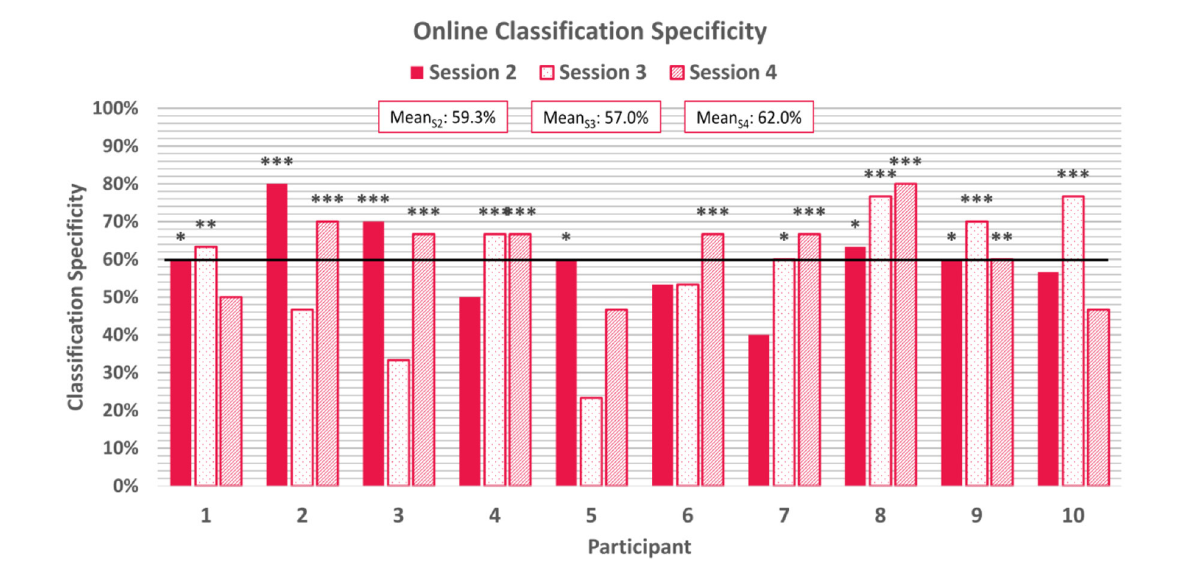
FIGURE7 Average classification specificity for each online session. Specificity refers to the correctly classified negative emotion-induction trials out of all negative emotion-induction trials. The horizontal line again represents the 95% confidence level threshold for the first online session. Sensitivities exceeding the upper limit of the 95%, 99%, and 99.9% confidence intervals of chance are marked with *, **, and ***, respectively.